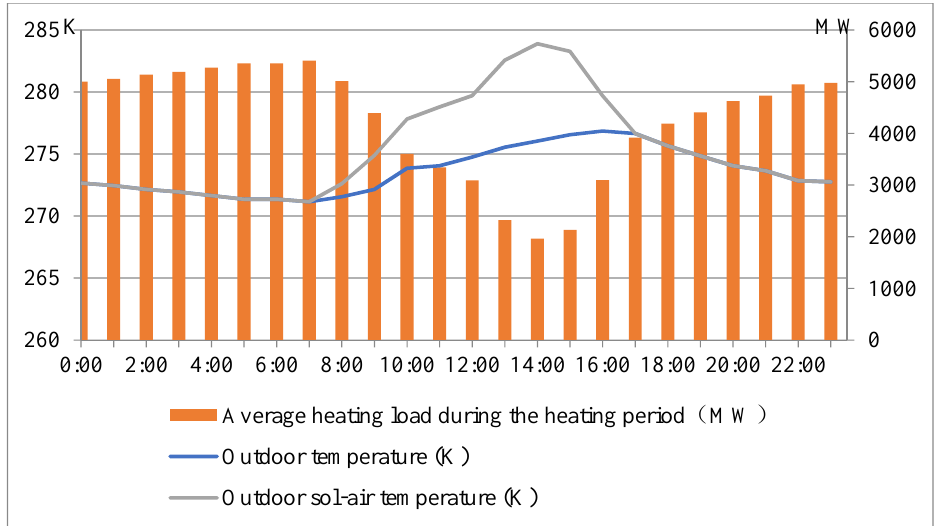
Figure 4. Hourly temperatures on a typical day and average heating loads in December in Xi’an. Table 1. Scenario analysis of peak-shaving ratios under different basic heating loads.